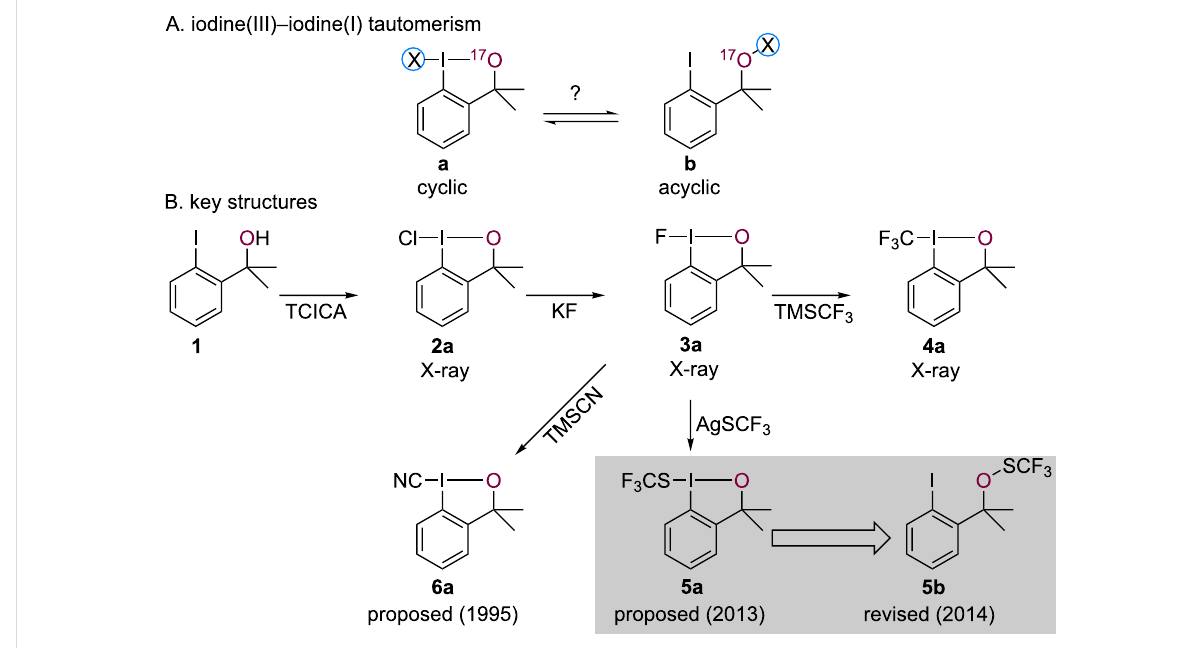
Figure 1: Tautomerism in iodine-based group-transfer reagents probed by 17 O NMR spectroscopy (A) and key structures investigated herein